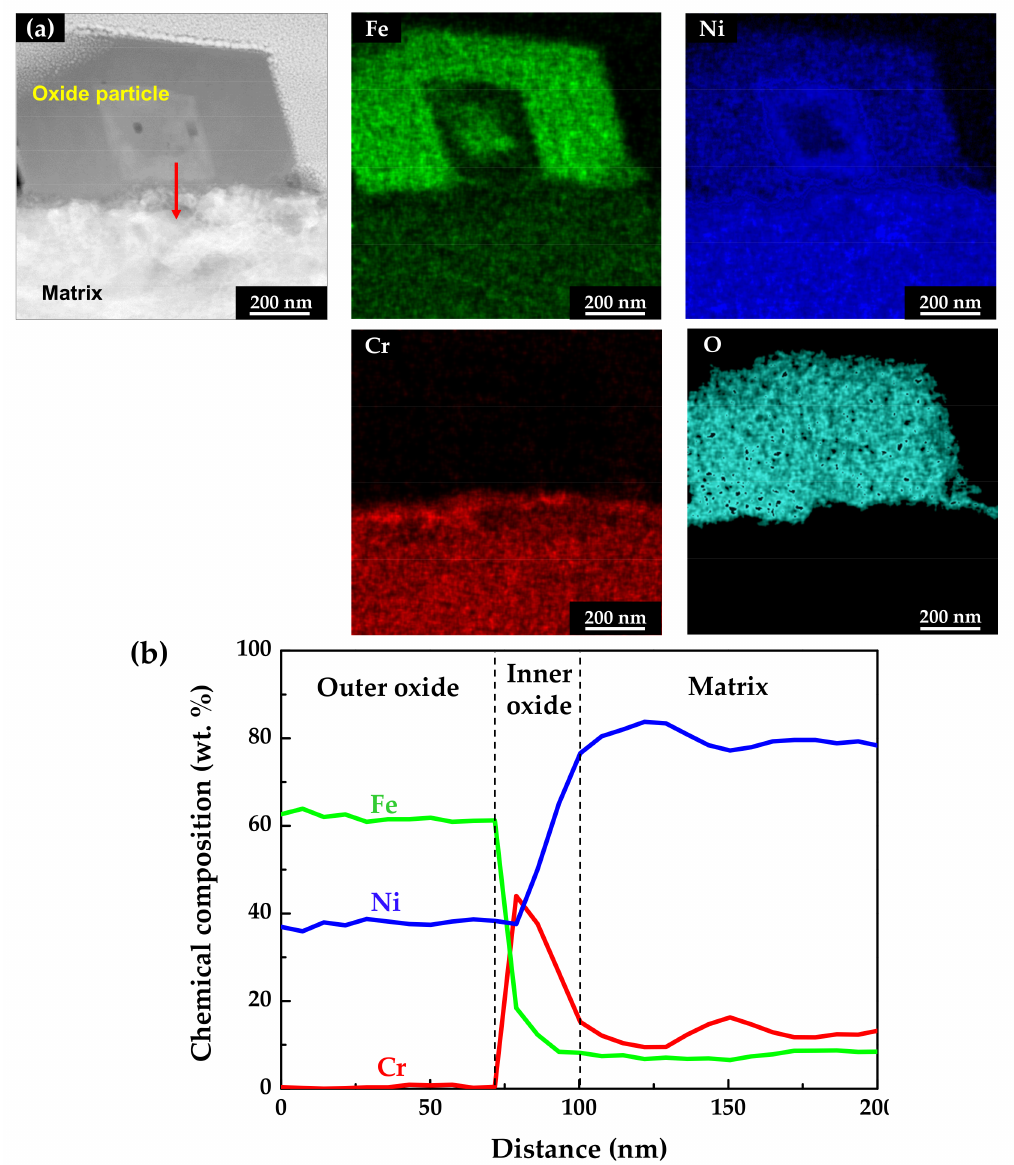
Figure 6. STEM image and EDS analyses of oxides formed on Alloy 600 specimens under the tensile stress condition: ( a ) EDS elemental maps and ( b ) EDS elemental line